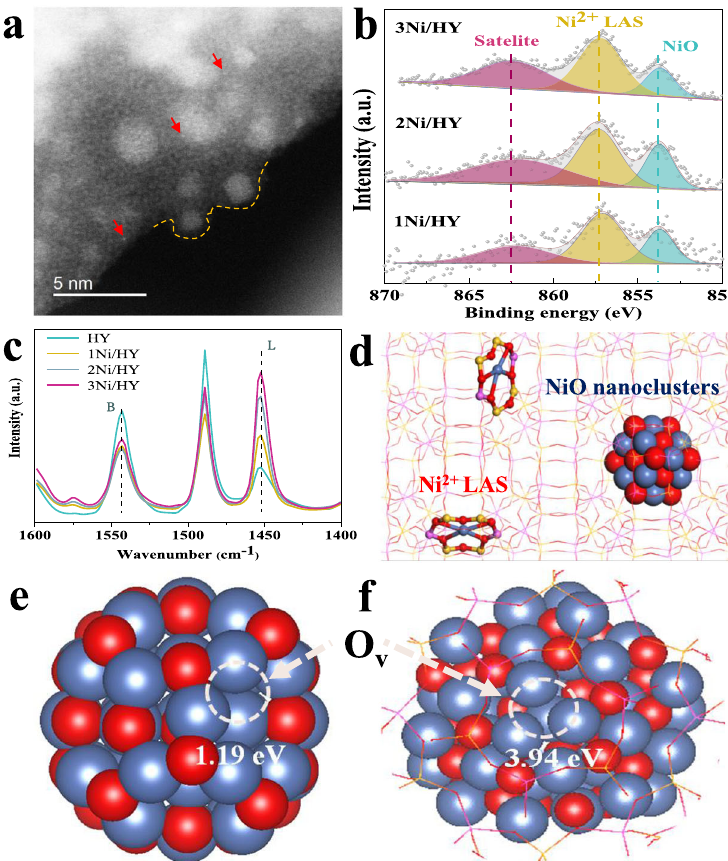
Fig. 1 Characterizations of the x Ni/HY. a AC-TEM image of 3Ni/HY sample. b XPS spectra of fresh x Ni/HY. c Pyridine adsorption FT-IR spectra of x Ni/ HY, where Brønsted (B) and Lewis (L) acid sites are observed at around 1540 and 1450 cm − 1 , respectively. d Scheme of the proposed local structure of Ni- modi fi ed HY. DFT calculation models and results of e 1 nm NiO cluster and f that con fi ned inside zeolite. (Ov stands for oxygen